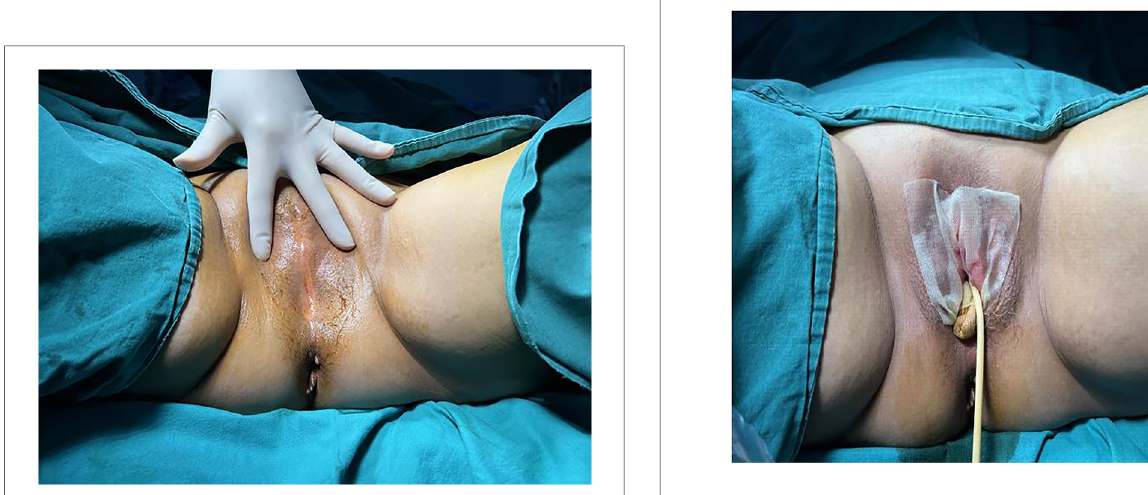
FIGURE 3 A piece of vaseline gauze was used to cover the vulvar adhesion and separation